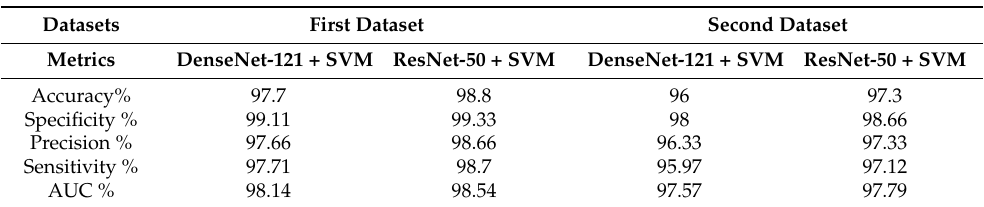
Table 3. Results for the evaluation of the hybrid approach in diagnosing the two datasets of malignant